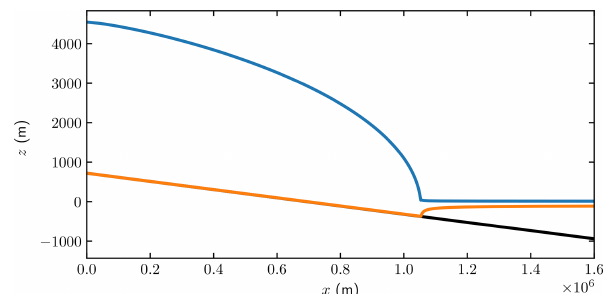
Figure 1. The initial ice geometry with height h (blue), ice base b (orange), and ocean bathymetry (black). The domains in Eq. (2) are the ice domain (cid:127) between the blue and orange curves, the upper surface (cid:48) s in blue, the lower boundary on the bedrock (cid:48) b and on water (cid:48) w in orange, (cid:48) u at x = 0, and (cid:48) d at x = L = 1 . 6 × 10 6